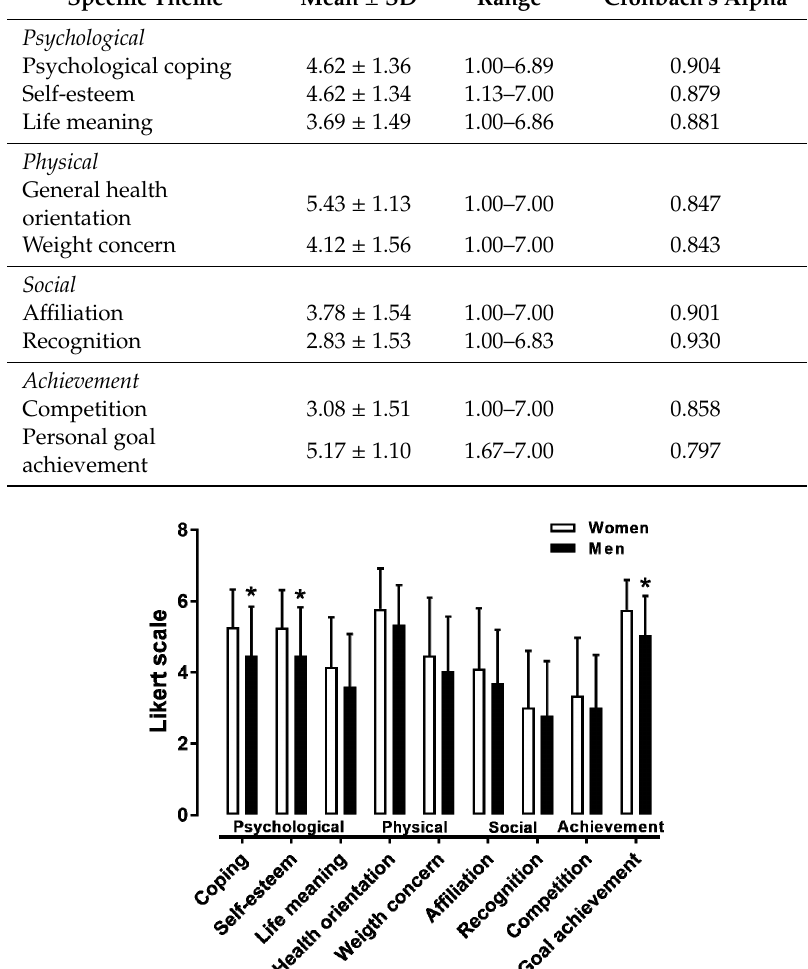
Table 1. Descriptive statistics and internal consistency of the nine Motivations of Marathoners Scales (MOMS) specific themes.